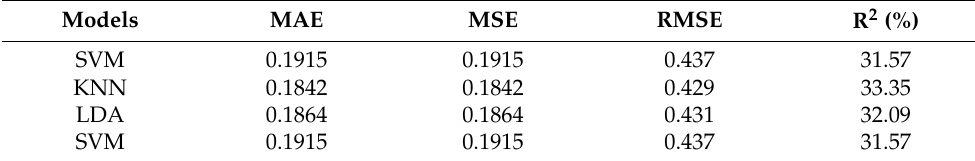
Table 11. Statistical analysis of the machine learning models using the Drebin dataset.